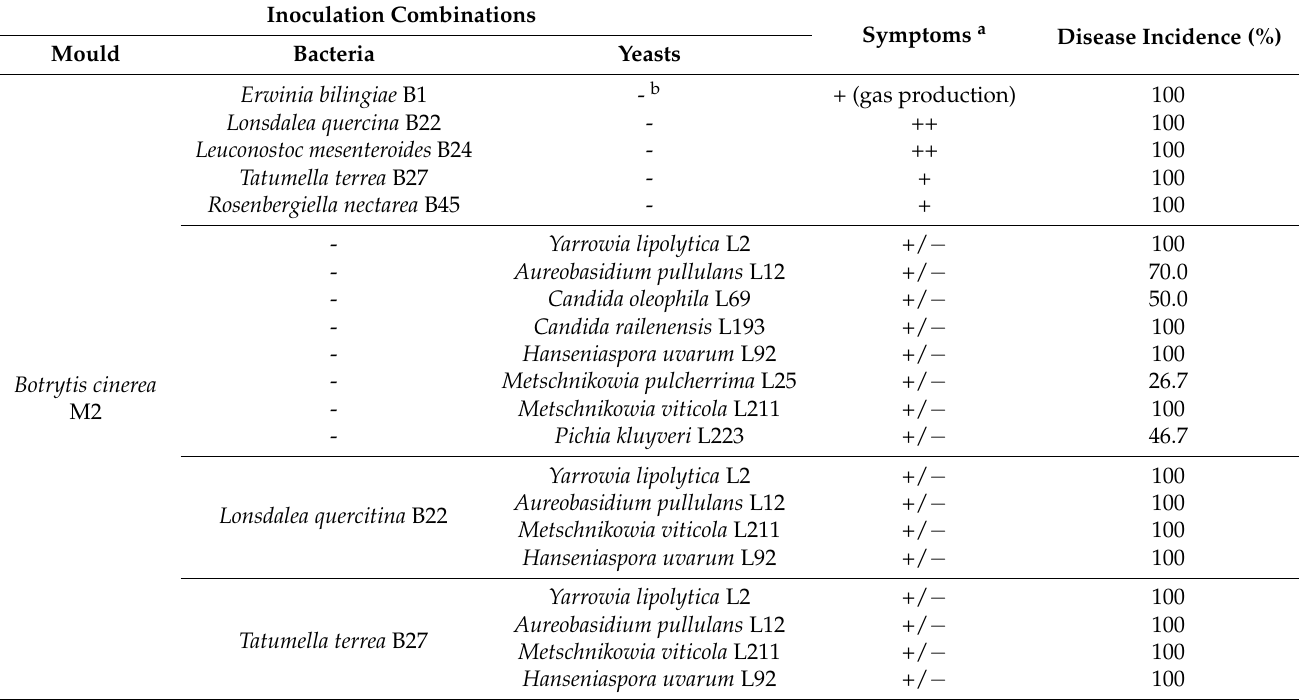
a Development of ‘aqueous spot’ symptoms: browning of tissues and mycelium development. +: symptoms are more similar to ‘aqueous spot’ than B. cinerea M2 alone; +/ − : decreased symptoms; ++: increased symptoms. b (-) microorganism that is not included in the inoculation